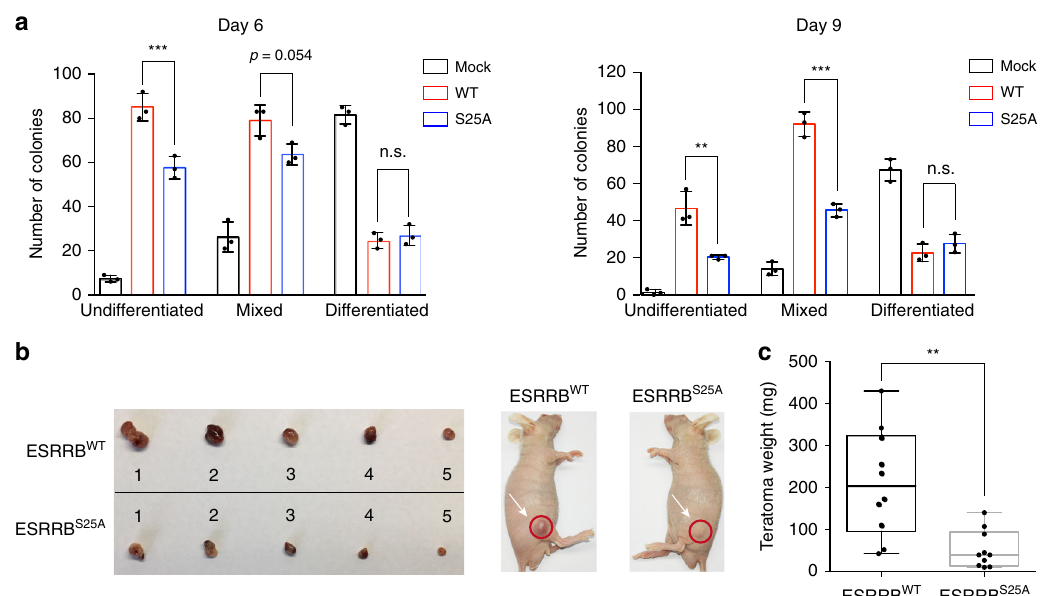
Fig. 5 ESRRB O-GlcNAcylation enhances self-renewal and pluripotency. a Clonogenicity assay of mESCs stably expressing Mock, FLAG-ESRRB WT and FLAG-ESRRB S25A . Bar graphs showing the statistical analysis of the undifferentiated, mixed and differentiated colonies in the absence of LIF for 6 days (left panel) and 9 days (right panel). Error bars represent mean ± s.d. Results are from three independent experiments. ** P < 0.01, *** P < 0.001, n.s., not signi fi cant (one-way ANOVA). b Teratoma formation in immunode fi cient mice by mESCs expressing FLAG-ESRRB or FLAG-ESRRB S25A . c Box plot showing the statistical analysis of teratoma weight. Median and quartile values are provided by the central line and box boundaries. Whiskers show min to max values. Results are from ten independent experiments. ** P < 0.01 (Student ’ s t -test). Source data for fi gures a , c are provided as a Source Data fi